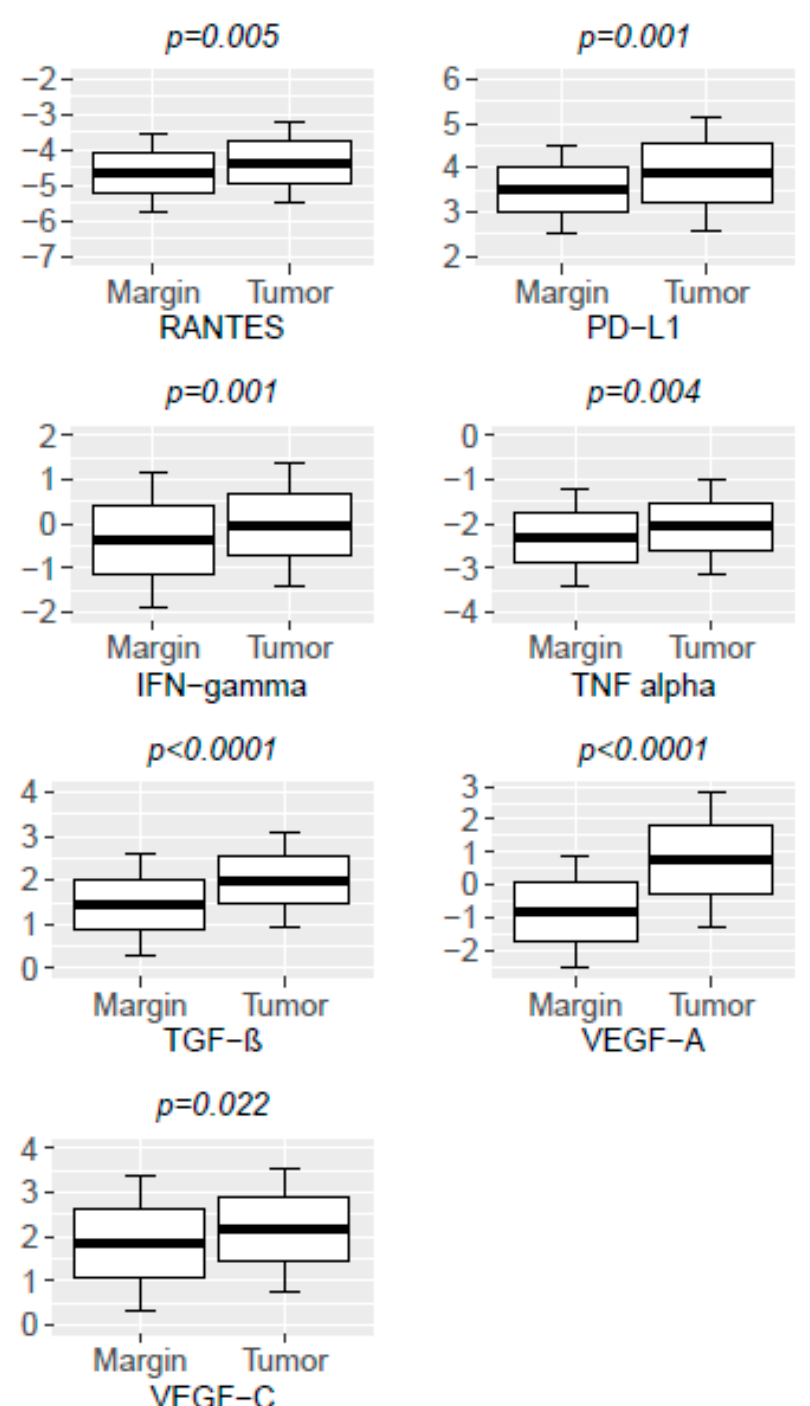
Figure 1. RANTES, PD-L1, IFN- γ , TNF- α , TGF- β , VEGF-A, and VEGF-C levels in the tumor and margin tissues.